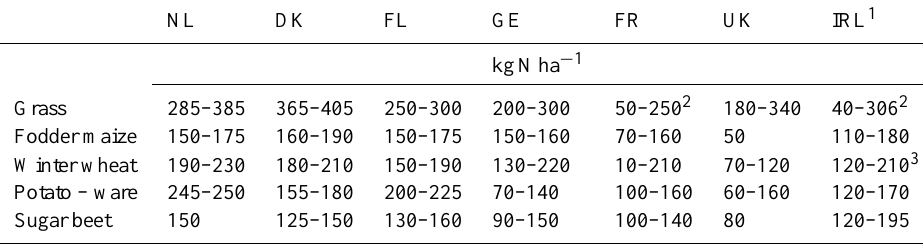
Table 11. Ranges of N recommendations in different regions for sandy to loamy soils with no effect of previous crop and a medium level of soil nitrogen supply (SNS). Relatively high N-recommendations are found in The Netherlands and Denmark, relatively low values in France and the UK (sources: Dijk and Berge, 2009; for FL Bodemkundige Dienst van Belgi¨e, 2012; for UK DEFRA, 2010 for FR COMIFER, 2011; for IRL Coulter and Lalor, 2008).